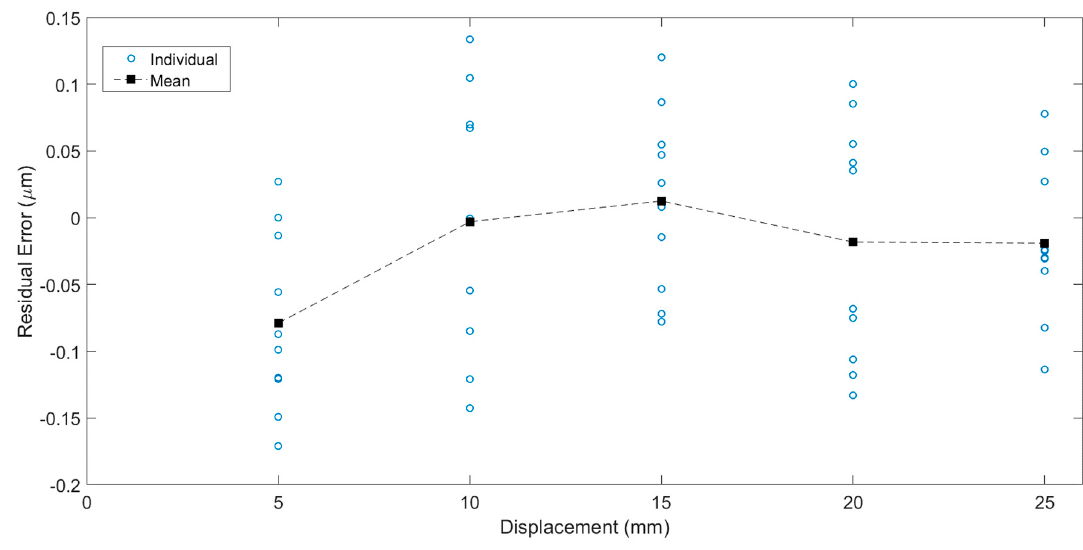
Figure 15. Positioning repeatability of image grating system.